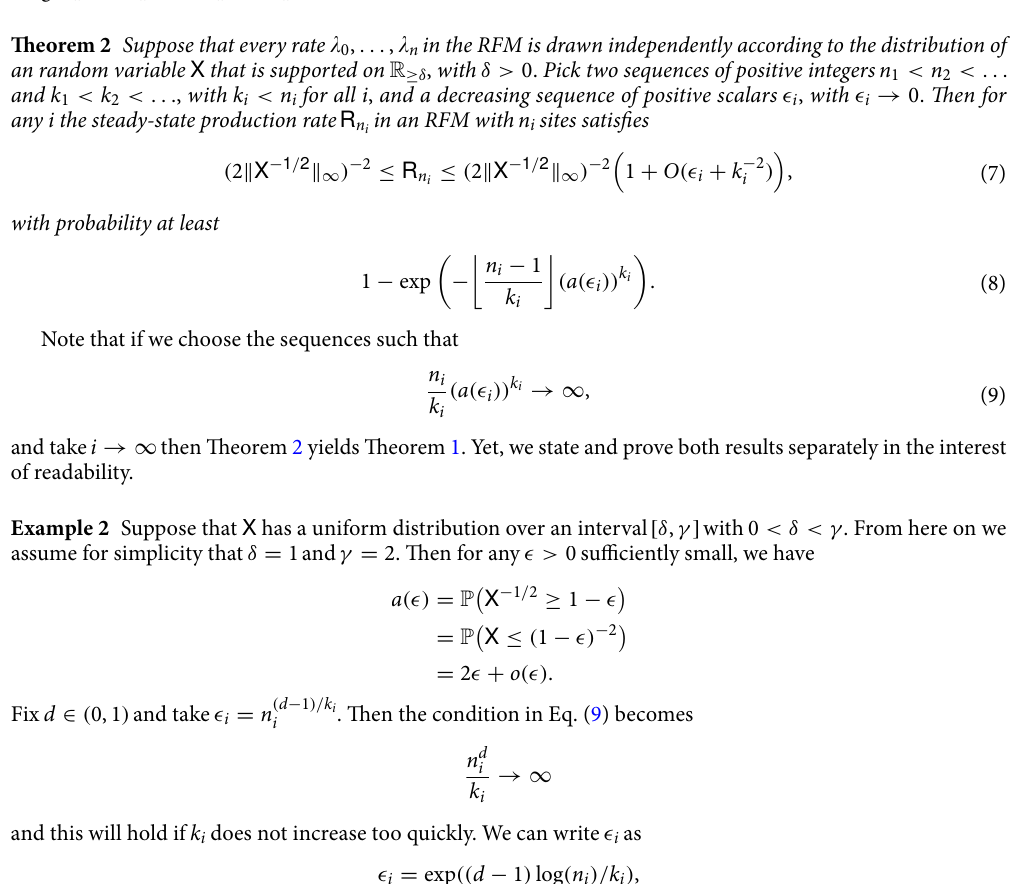
Figure 3. Histograms of 10, 000 R n values in Example 1 for n The theory predicts that as n